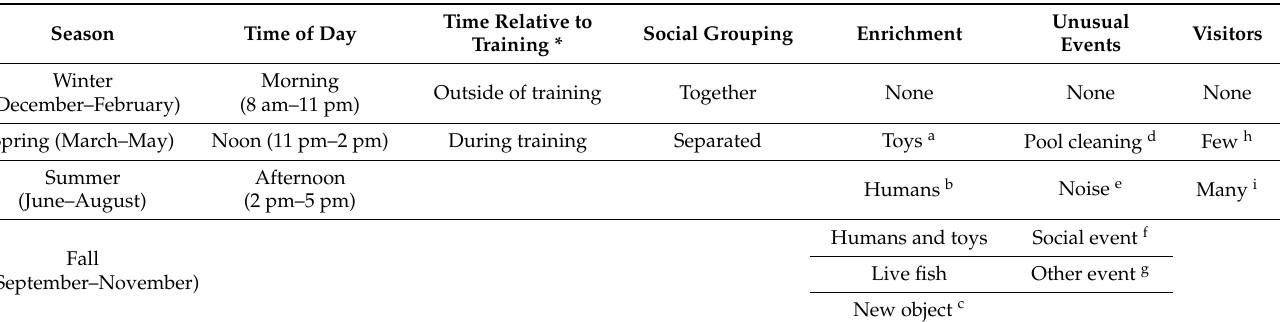
Table 2. Context